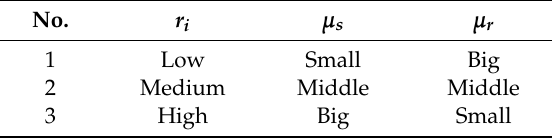
Figure 3. Membership function: ( a ) Production rate of a machine; ( b ) Certainty value of sleep decision; ( c ) Certainty value of running decision. Table 2. The fuzzy rules for certainty factor reasoning.